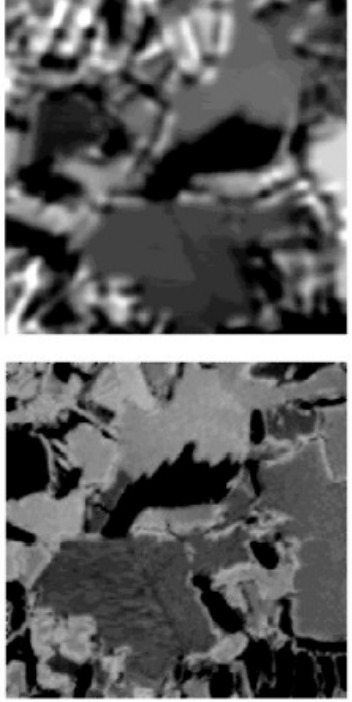
Figure 14. Comparison of eddy current and acoustic microscopic images of a coarse grained Ti-6Al-4V sample from nearly the same area of the